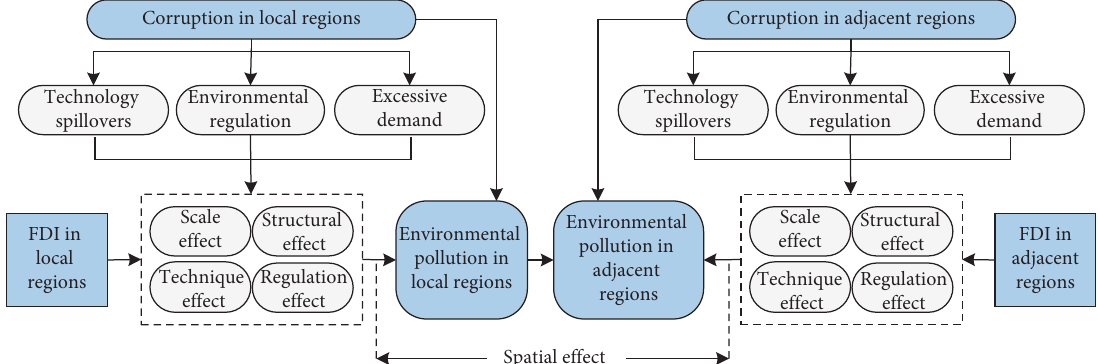
Figure 1: The effects of FDI and regional corruption on environmental pollution from a spatial Table 1: Variables definition and descriptive statistical results. regional corruption level.